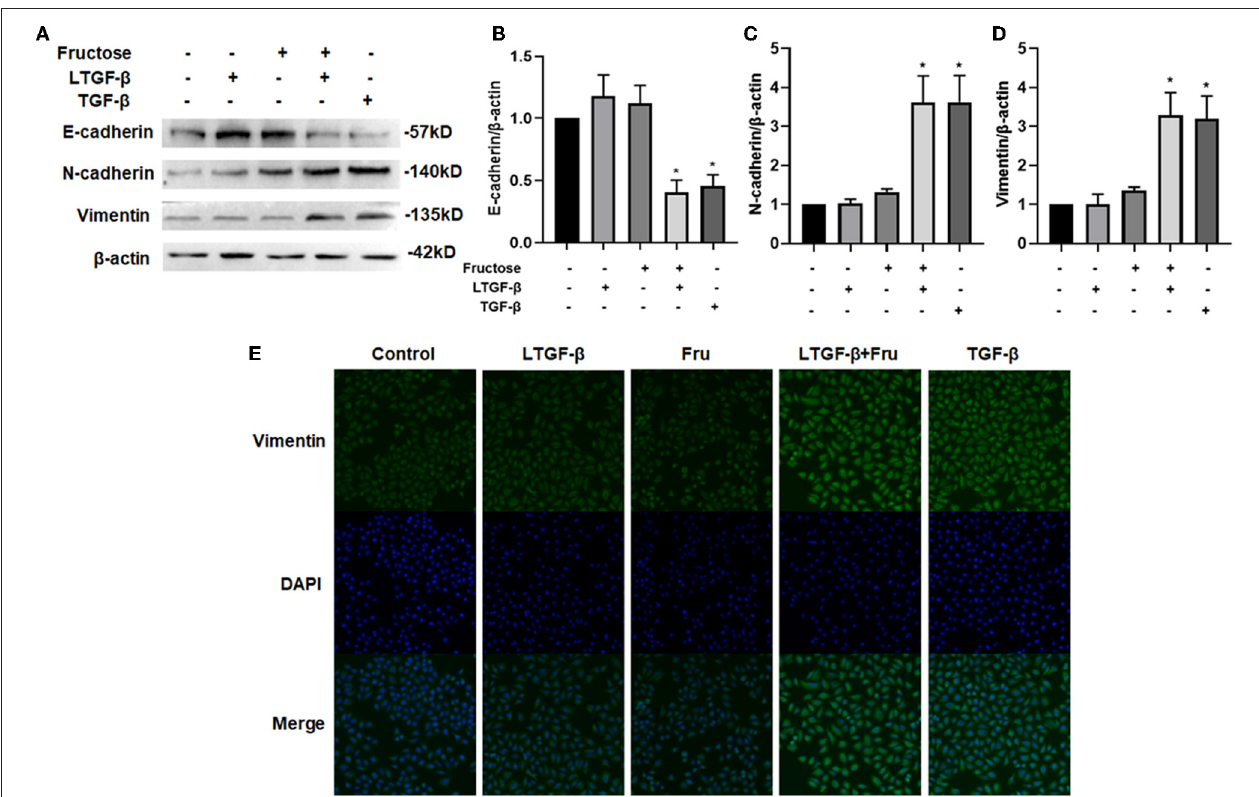
FIGURE 4 | Effect of fructose on the latent TGF- β 1-induced EMT process in A549 cells. Expression of E-cadherin, (A and B) N-cadherin, (A and C) and Vimentin (A and D) in the lysates of A549 cells treated under the indicated condition was assessed by Western blot. Representative gels were shown, and data were presented as the Mean ± S.E.M ( n = 3) and analyzed using one-way ANOVA followed by Tukey’s test. The relative value was set as fold induction to the control set at 1, normalized to β -actin. (E) Additionally, the vimentin expression was determined by immunofluorescence (200 × ). * p < 0.05, vs. control group. Control, 0mM fructose; Fru, 10mM fructose; LTGF- β 1, latent TGF- β 1; LTGF- β 1 + Fru, latent TGF- β 1 + 10mM